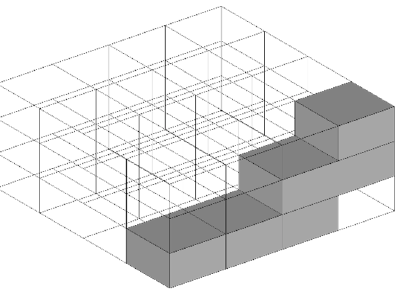
Figure 8. Batches of 6 blocks violating Rule 6. Total length is too long.